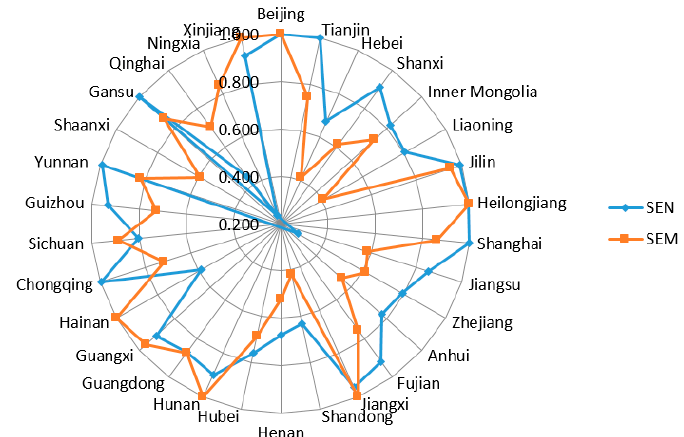
Figure 7. The SEN and SEM of 30 Chinese provinces in 2006.